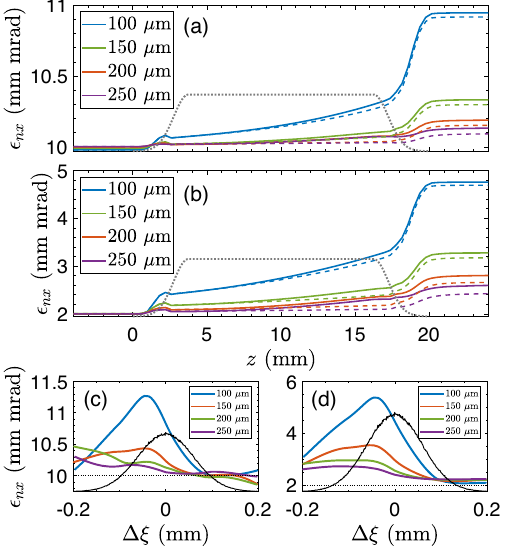
FIG. 7. (a,b) Evolutions of the normalized emittances along the APL with different initial electron beam sizes. The APL plasma (gray-dashed line in arbitrary units) is present between z ¼ 0 and 20 mm, whereas the negative z indicates the drift space through which the electron beam propagates. Solid lines indicate the emittance evolutions, including the wakefield effect from both the proton bunches and electrons, whereas the dashed lines represent the cases without proton bunches. (c – d) Slice emittances after propagation through the APL. Black line: Longitudinal electron beam distribution (arbitrary units), where the head is placed at positive Δ ξ and the tail is located at negative Δ ξ . The initial emittances of the electron beams are (a,c) 10 and (b,d) 2 mm mrad, respectively.